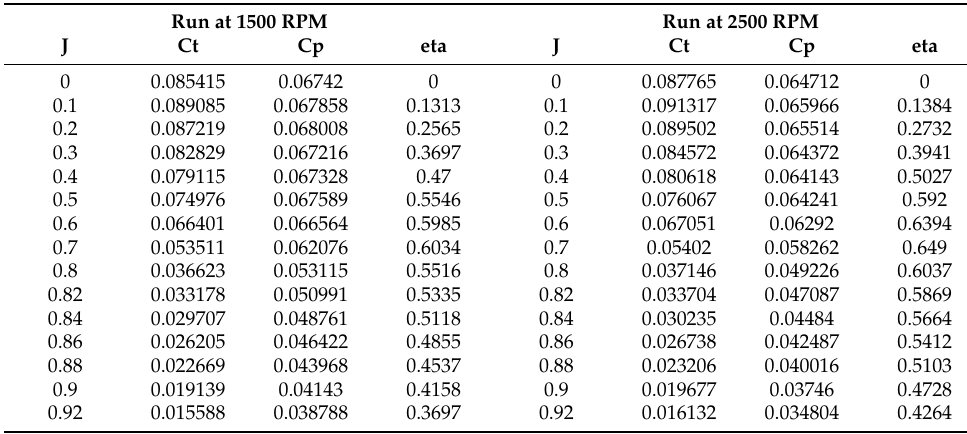
Table A28. BEMT 18 × 14 APC propeller